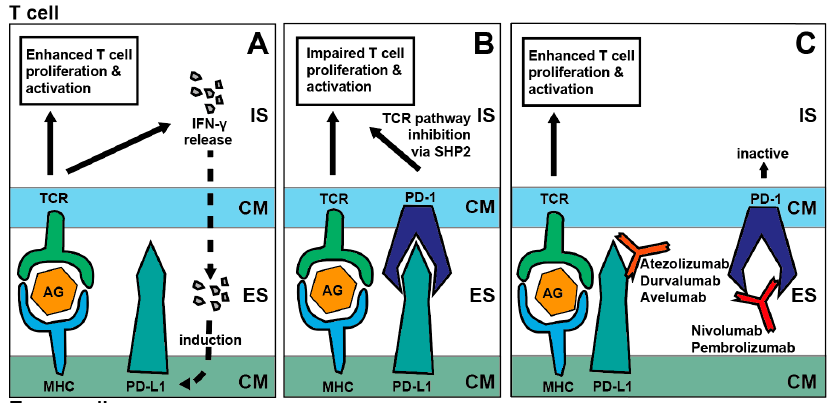
Figure 1. Mechanism of PD-1 / PD-L1 blockade. ( A ): IFN- γ release upon TCR activation induces PD-L1 expression, ( B ): Interaction of PD-1 / PD-L1 inhibits TCR signaling via SHP2, ( C ): Blockade of the PD-1 / PD-L1 axis via atezolizumab, durvalumab, avelumab, nivolumab or pembrolizumab